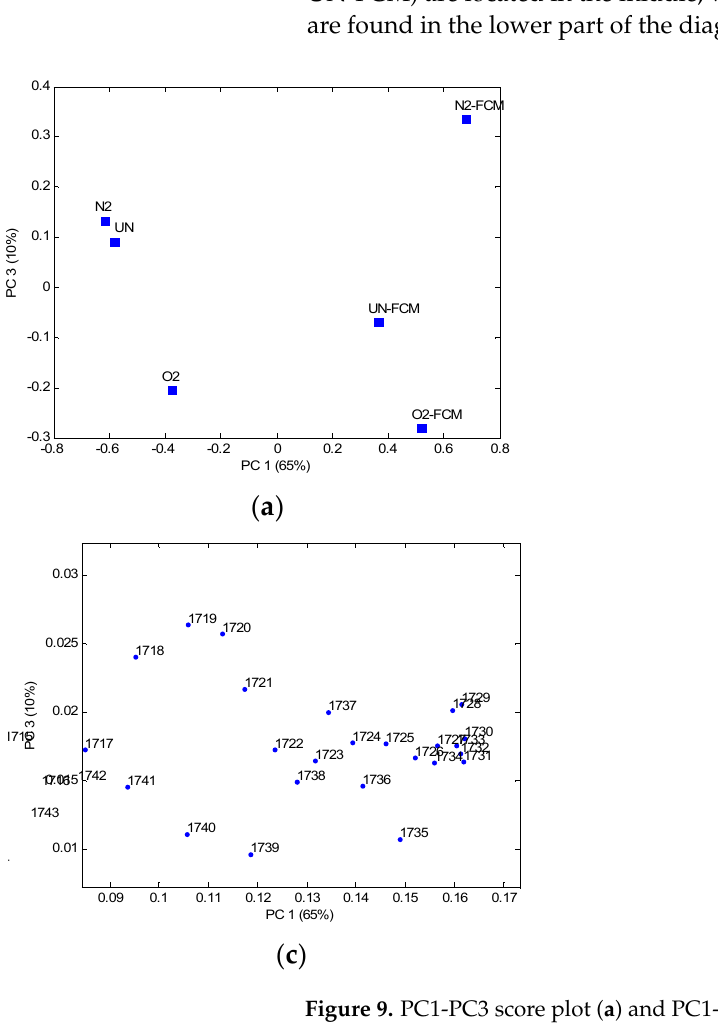
permeability). Examining the two score plots, one can assign a physical mean to two of the first three PCs. As mentioned above, PC1—the horizontal axis in Figure 8a—is related to the presence (N 2 -FCM, O 2 -FCM, UN -FCM) or absence of microcapsules (N 2 , O 2 , UN) on the samples. On the other hand, PC3—the vertical axis in Figure 9a—separates the samples in terms of presence and type of plasma treatment: in the upper part of the diagram, we find both N 2 plasma-treated samples (N 2 -FCM and N 2 ), untreated samples (UN and UN-FCM) are located in the middle, while both O 2 plasma-treated samples (O 2 , O 2 -FCM) are found in the lower part of the diagram. Figure 8. PC1-PC2 score plot ( a ) and PC1-PC2 loading plots ( b – d ).